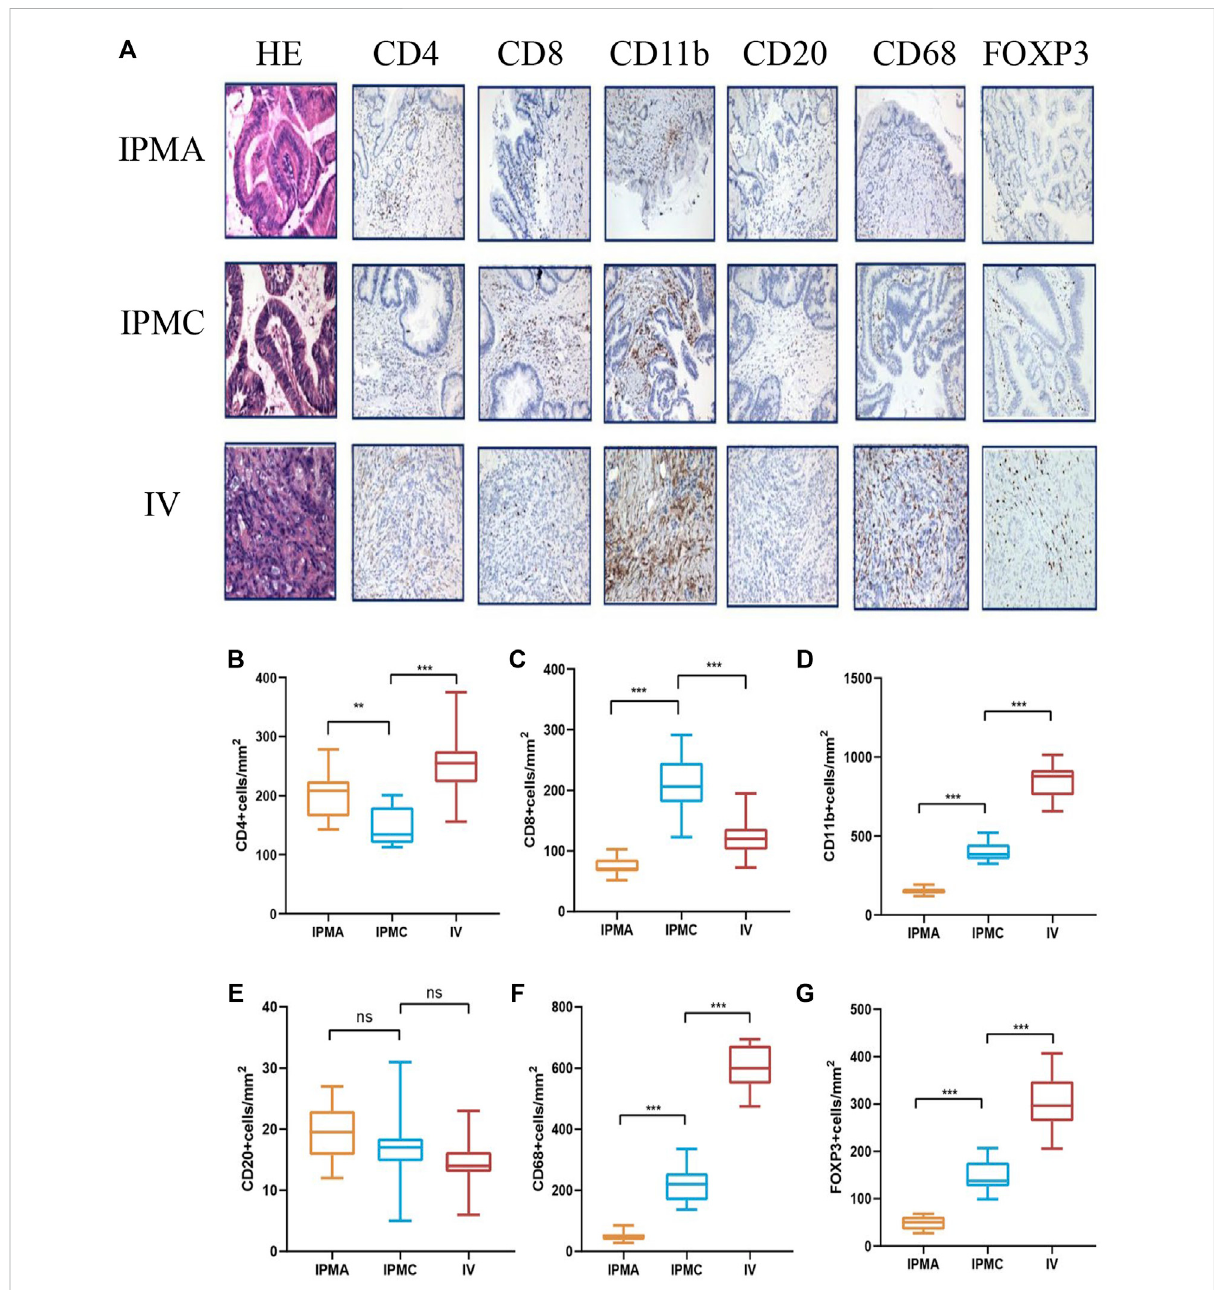
FIGURE 4 RepresentativeHEandIHCimagesofdifferentdiseasestagetissues. (A) Fromlefttoright,immunohistochemicalstainingforCD4,CD8,CD11b, CD20, CD68, and FOXP3. (B – G) Histogram showing the density of in fi ltrating